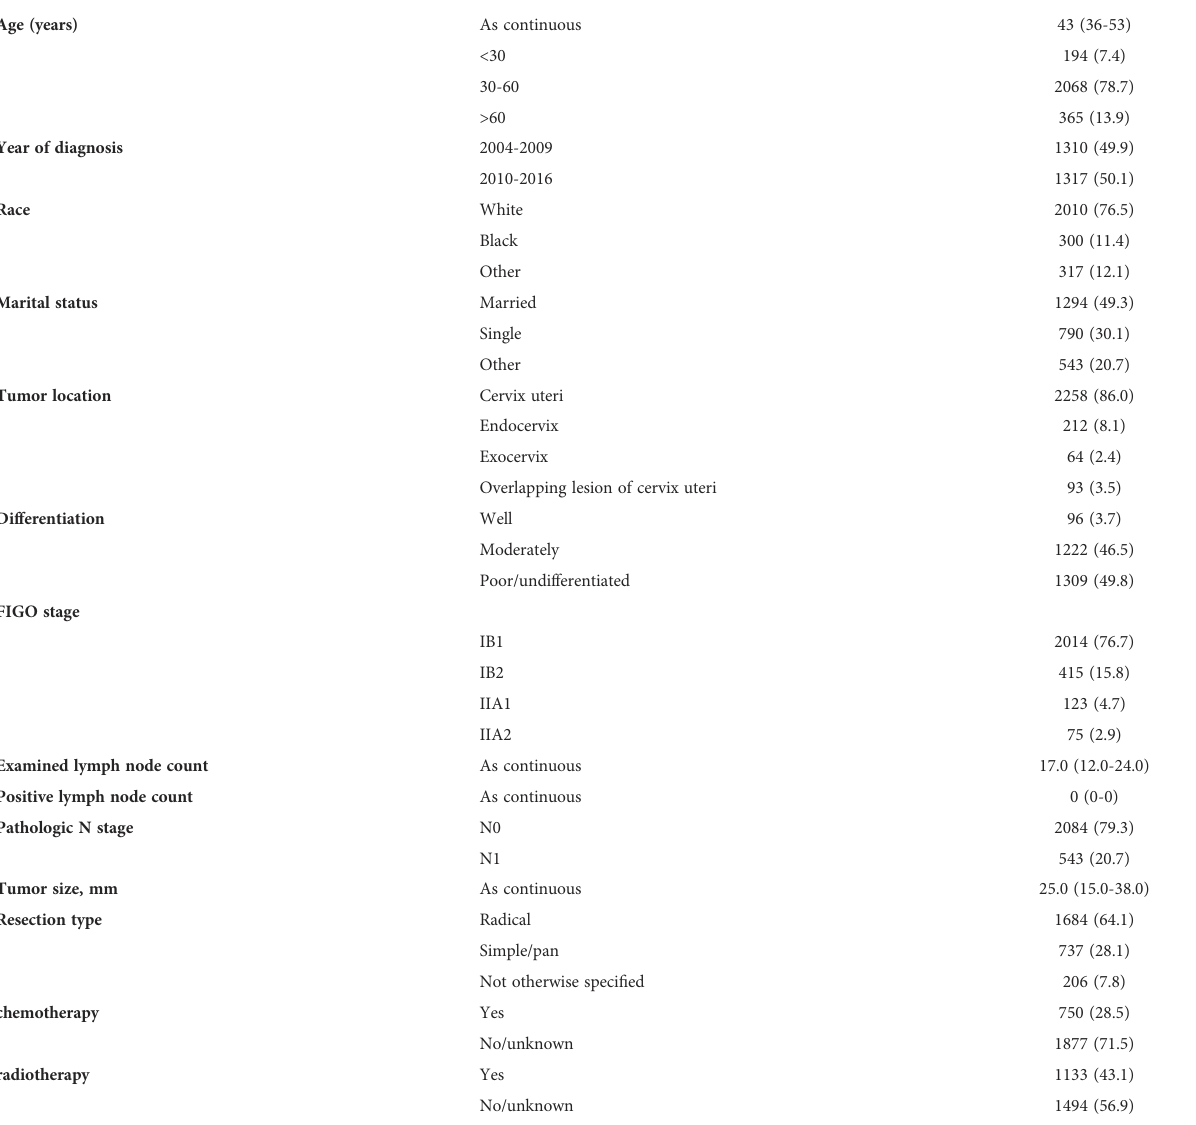
TABLE 1 Baseline clinicopathological